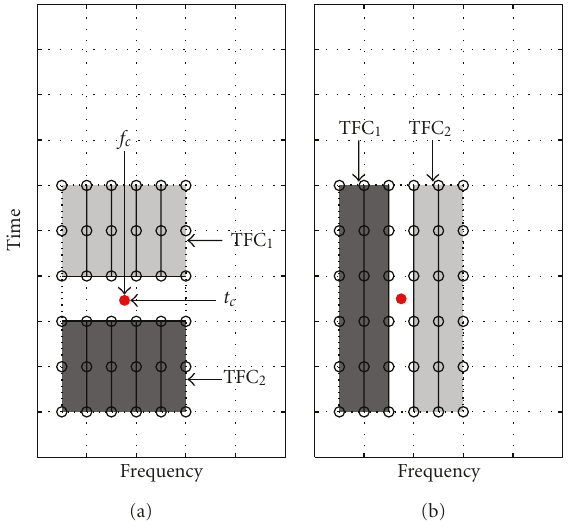
Figure 2: Cartoon of a pair of time-frequency cells (TF C 1 and TF C 2 ) placed in a time-frequency window (surrounded by the thick dotted line) is shown using two di ff erent gray shades. Panels (a) and (b) show relative location of TFCs used for dissimilarity estimation of BB and NB changes, respectively. The red filled circles in the middle of the TF cells correspond to the mean values of time ( t c ) and frequency f c of respective TF